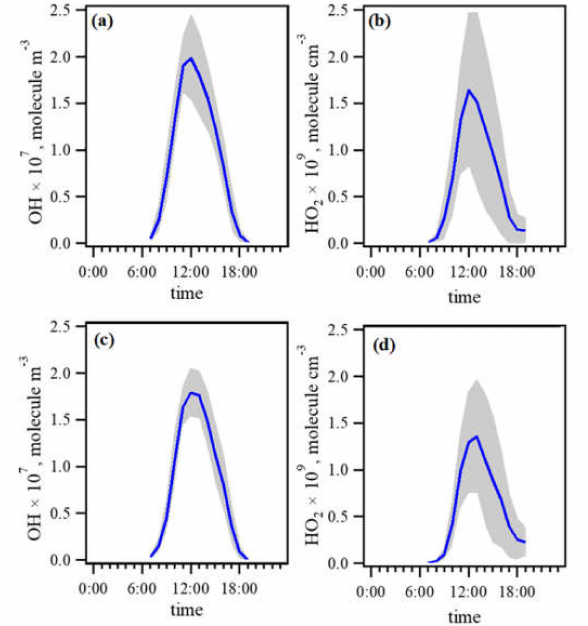
Figure 4. Mean diurnal variations of the OH and HO 2 concentrations for ( a , b ) the DSH site and ( c , d ) the PD site during pollution episodes (11–16 July and 18–26 July) simulated using the observation-based model (OBM). The shaded gray areas represent the standard deviation of simulated radical concentrations at each